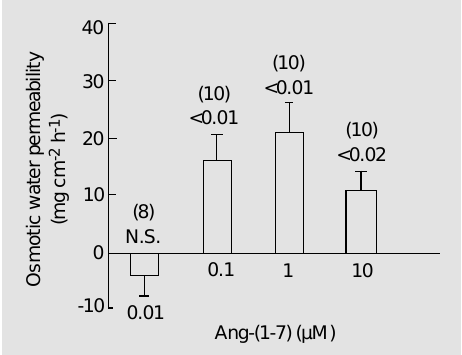
Figure 1 - Effect of different Ang- (1-7) concentrations on osmotic water permeability in